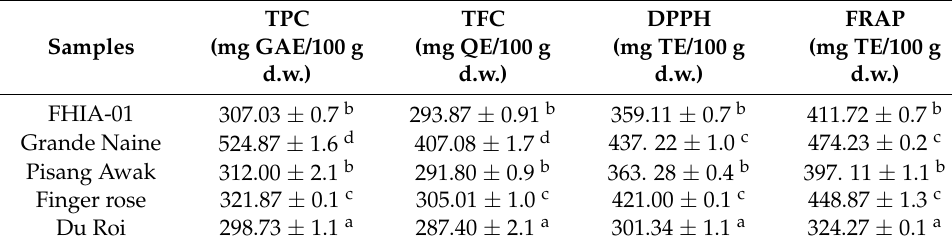
Table 6. Total flavonoid content (TFC), total phenolic content (TPC) of green banana flour. TPC TFC DPPH FRAP Samples (mg GAE/100 g (mg QE/100 g (mg TE/100 g (mg TE/100 g d.w.) d.w.) d.w.) d.w.) FHIA-01 307.03 ± 0.7 b Grande Naine Finger rose 321.87 ± 0.1 c 305.01 ± 1.0 c 421.00 ± 0.1 c Du Roi 298.73 ± 1.1 a 287.40 ± 2.1 a 301.34 ± 1.1 a 324.27 ± 0.1